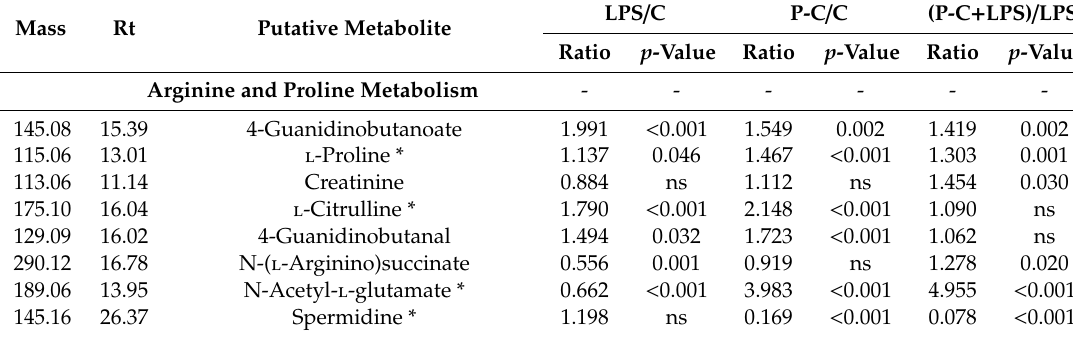
Table 2. Significantly changed metabolites in THP-1 cells treated with either lipopolysaccharide (LPS) or Cameroonian propolis (P-C) extract alone in comparison with untreated controls and in cells treated with a combination of P-C and LPS compared with LPS treated cells. The results show the majority of affected metabolites. (0.5 µg/mL LPS; 70 µg/mL P-C).